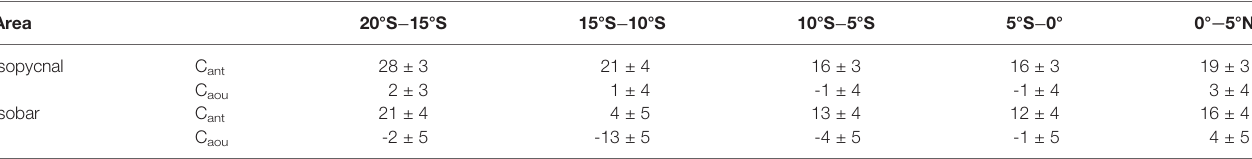
TABLE 1 | Water-column storage changes above 3000 dbar in anthropogenic (C ant ) and natural (C aou ) carbons (mol m -2 ) from 1995 to 2019 based on property comparisons of isopycnal and isobar surfaces. .